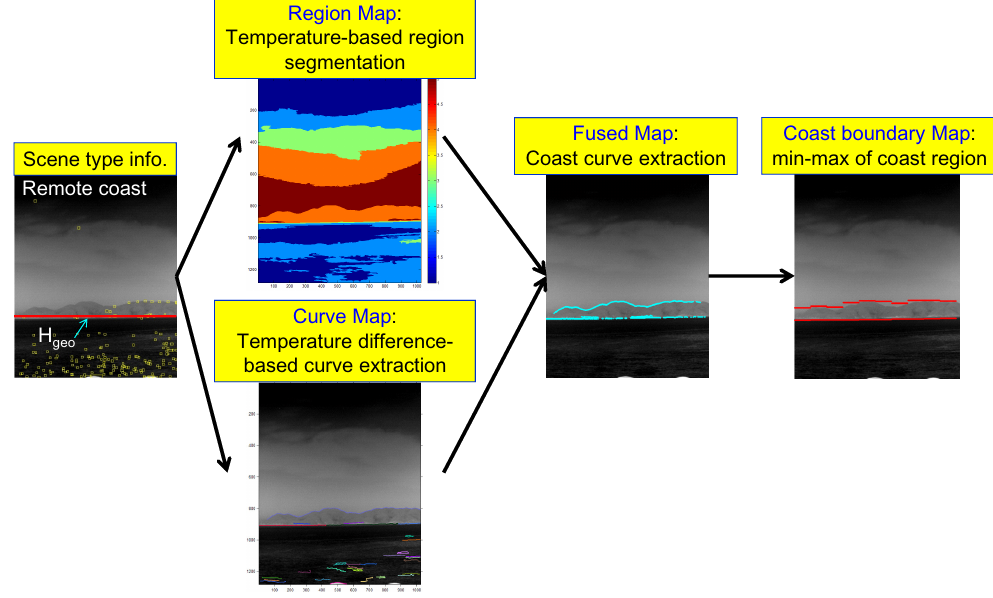
Figure 13. Proposed coast region detection flow given in the scene type